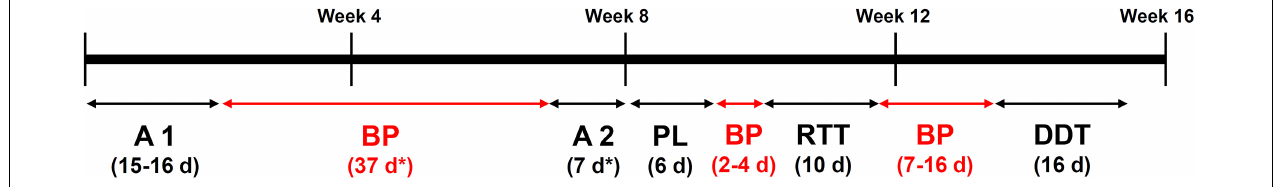
FIGURE 1 | Timeline of the different behavioral experiments performed in this study by the male and female cohort. A, adaptation phase; BP, break phase; PL, place learning; RTT, reaction time task; DDT, delayed discounting task; d, days. *Males